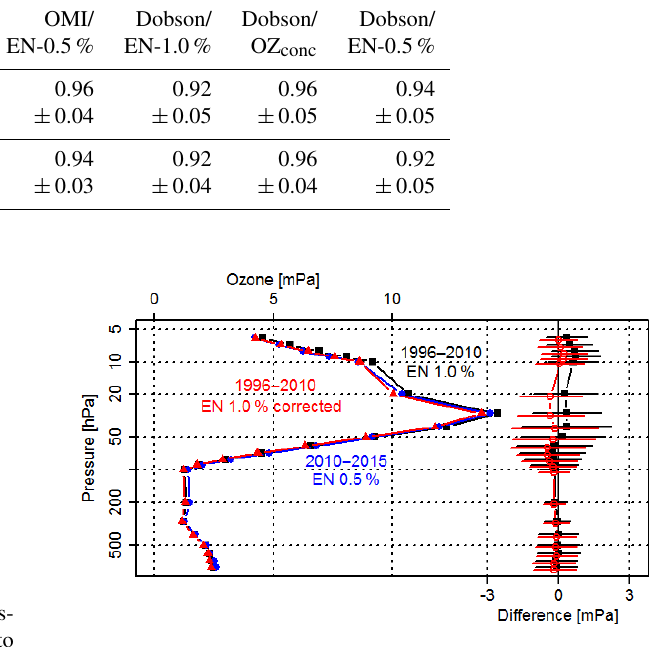
Figure 10. On the left (upper scale), mean ozone profile for the EN- 1.0% period in black, EN-0.5% period in blue, and corrected EN- 1.0% profile using OZ conc in red for the Nairobi data set. On the right (lower scale), the difference between the mean (1996–2010) ozone profiles and the mean (2010–2015) profiles before and after (black and red, respectively) correction for the change of solution concentration that occurred in 2010. A small offset of the pressure scale is used to avoid overlapping error